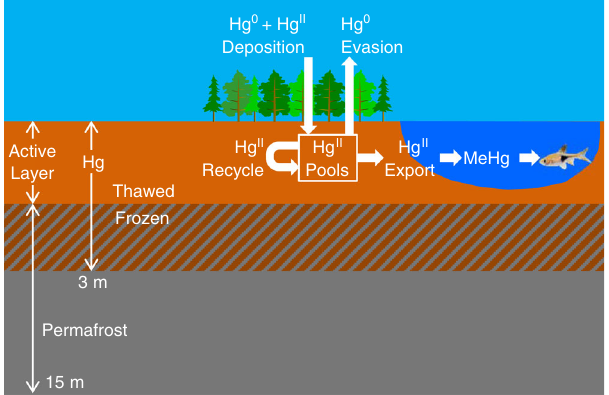
Fig. 1 A schematic of our terrestrial mercury (Hg) model. The soil extends down to 15 meters with an active layer that thaws in summer and refreezes in winter. The organic carbon and Hg extend down to three meters. Hg deposits onto the surface from the atmosphere and bonds to plant and soil organic matter. As organic matter decays, elemental mercury (Hg 0 ) is released into the atmosphere, some mercury cation (Hg II ) is exported into rivers, and the remaining Hg II is recycled back into the organic matter. We use empirical relationships to estimate methyl mercury (MeHg) concentrations in water from Hg II export and total Hg concentrations in fi sh from MeHg